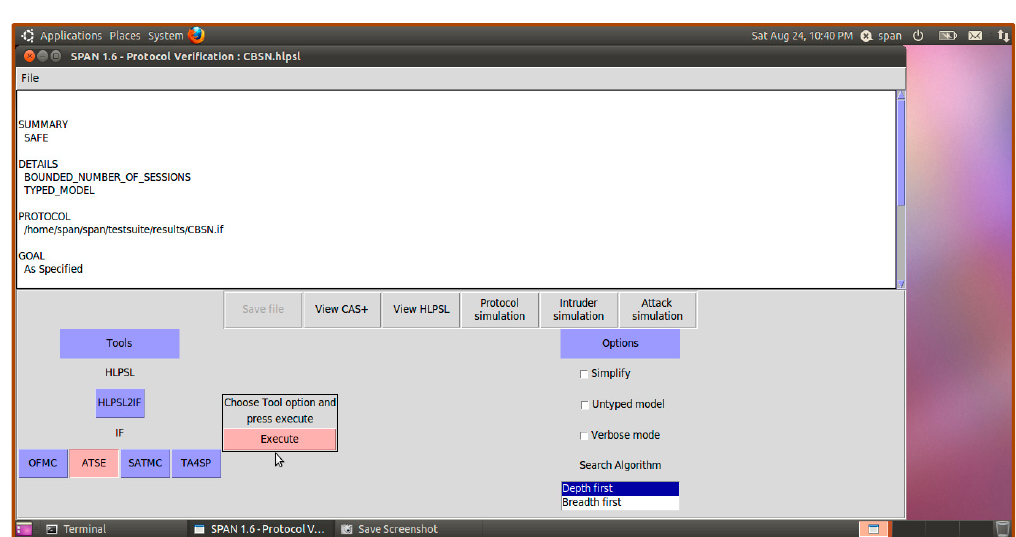
Figure A1. Simulation result of OFMC.